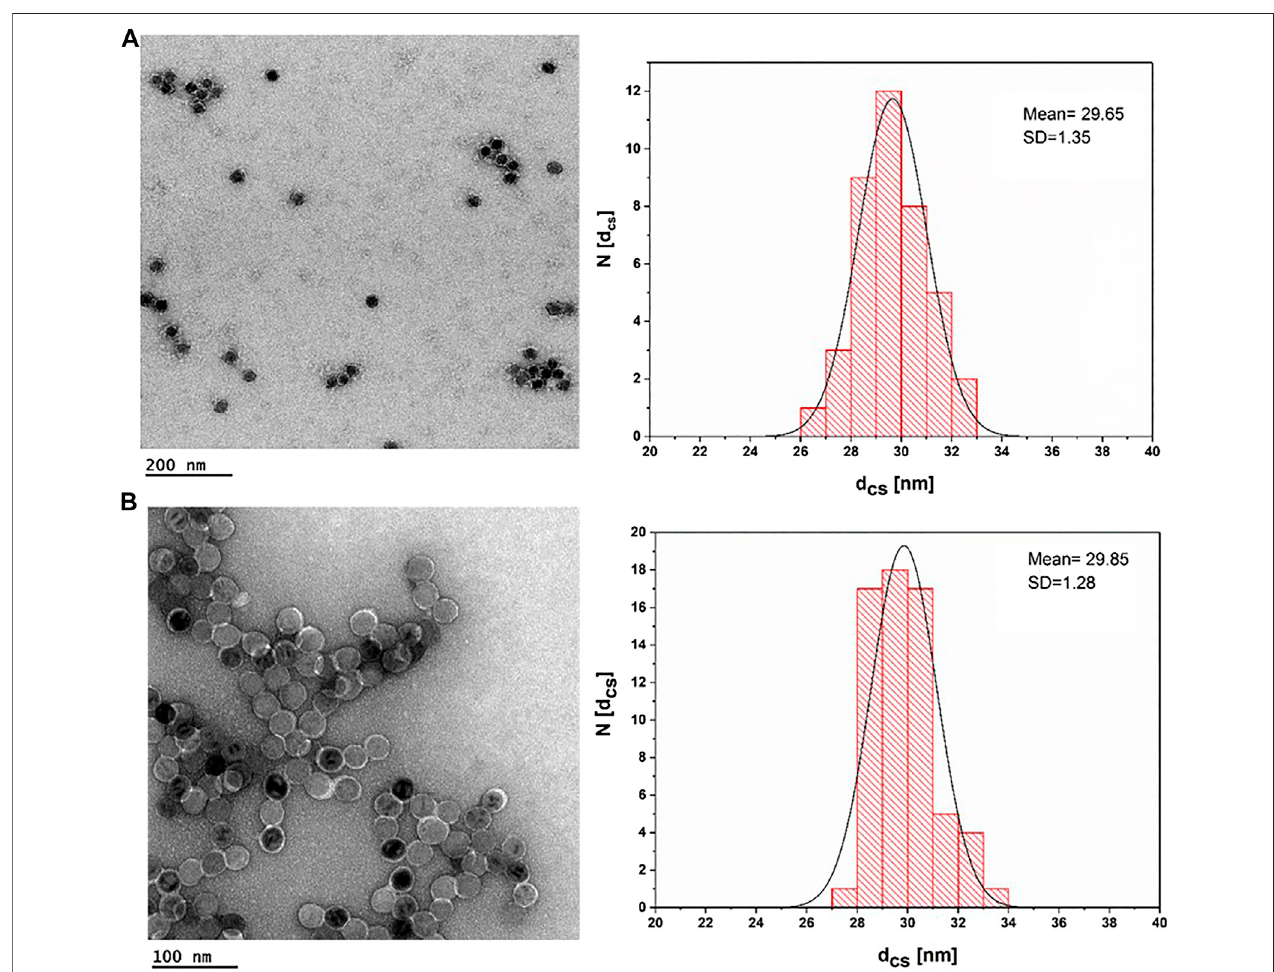
FIGURE 4 | TEM images of IONPs after negative staining with uranyl acetate. (A) IONP cores (d c (cid:2) 17.6 ± 0.91) plus an organic shell of PMA – DDA, resulting in d cs (cid:2) 29.65 ± 1.35; the scale bar corresponds to 200 nm. (B) IONP cores (d 1.28; the scale bar is 100 nm.